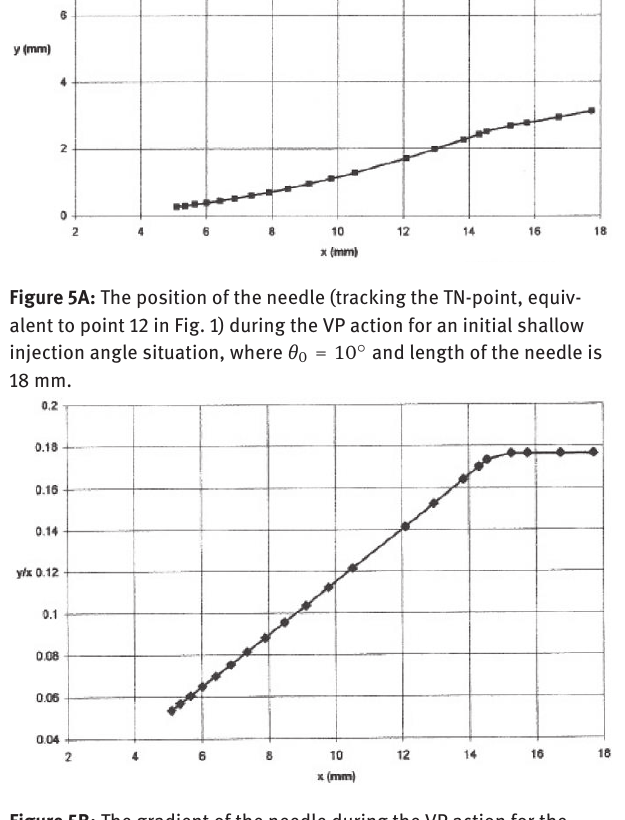
Figure 5B: The gradient of the needle during the VP action for the motion corresponding to Fig.